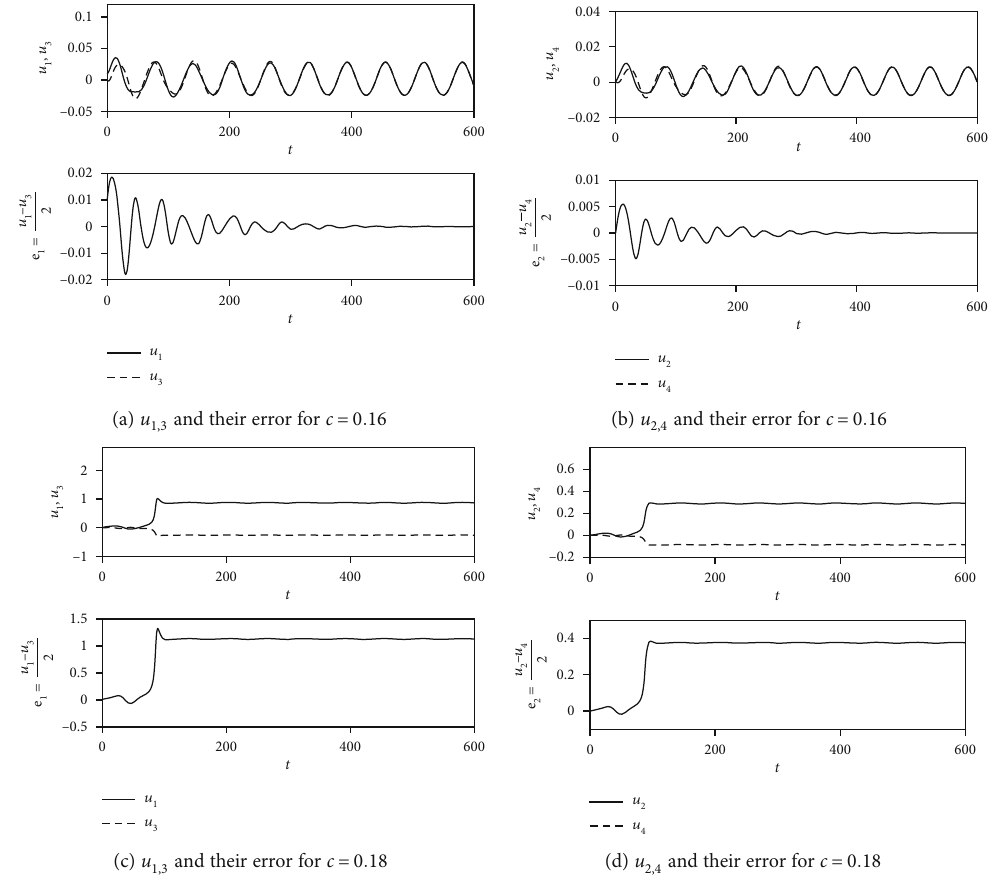
Figure 2: The dynamics of u and synchronization errors in Equation (3) with I = 0 : 01 , ω = 0 : 1 . (a) The dynamics of u 1,2,3,4 between them for c = 0 : 16 . (b) The dynamics of u and the error between them for c = 0 : 16 . (c) The dynamics of u 2,4 them for c = 0 : 18 . (d) The dynamics of u and the error between them for c = 0 : 18 . The initial conditions are taken as u 2,4 ð 0 Þ = u ð 0 Þ = 0 = u 3 4